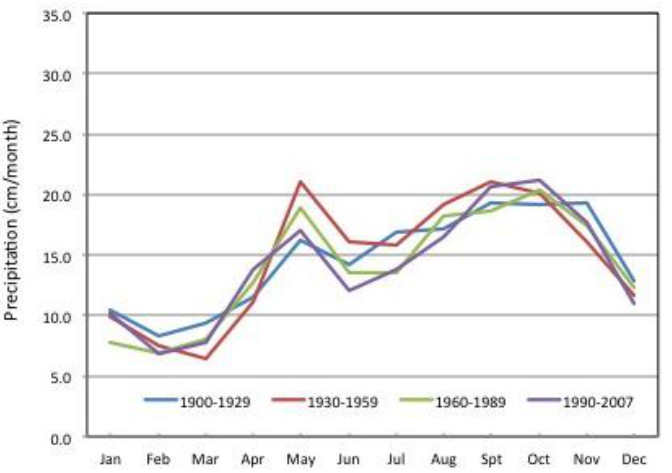
Figure 16. Moist forest annual cycle monthly precipitation by period.